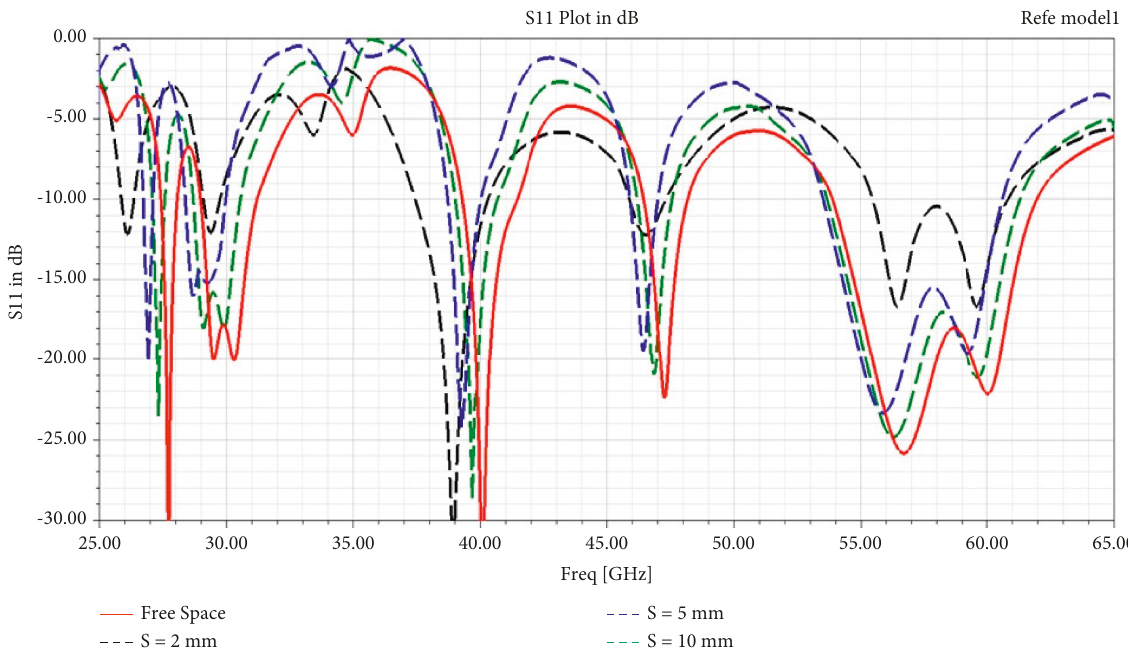
Figure 12: S performance of the optimized antenna at various proximity from the human 11 Table 4: On-body simulation performance of the optimized antenna at various distances from the body model. Placement Resonance frequency (GHz) Bandwidth (GHz) Peak (dB) gain Peak (dB) directivity 26.1 On-body, 2mm